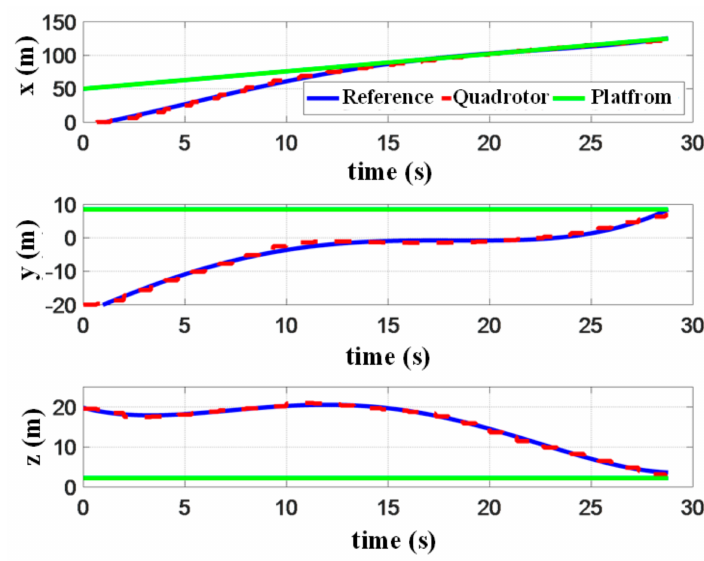
Figure 20. Position of the quadrotor and platform in the experiment.